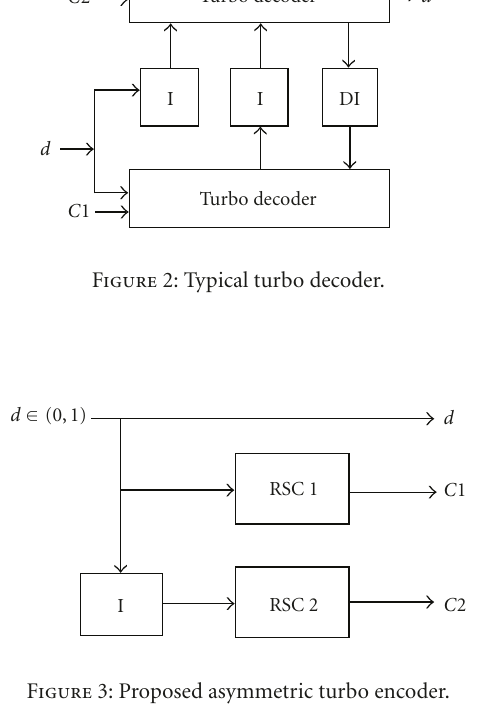
Figure 3: Proposed asymmetric turbo encoder.